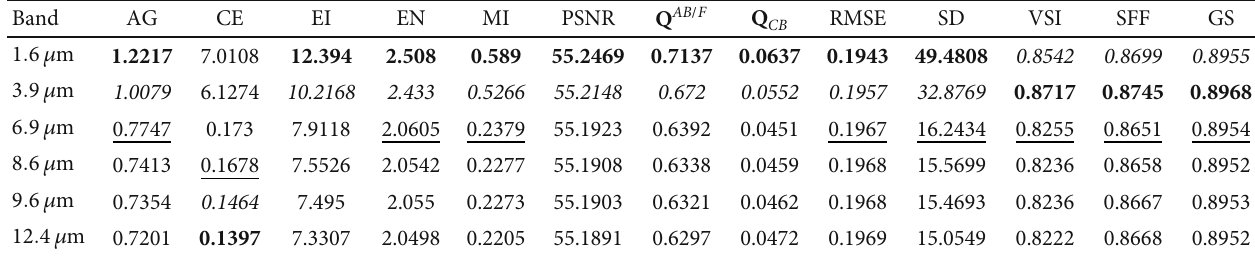
Figure 9: Example infrared images of di ff erent spectra. Table 7: Average evaluation metric values of the proposed method of di ff erent spectra on the SDD dataset. The best three values of each metric are marked as bold, italic, and